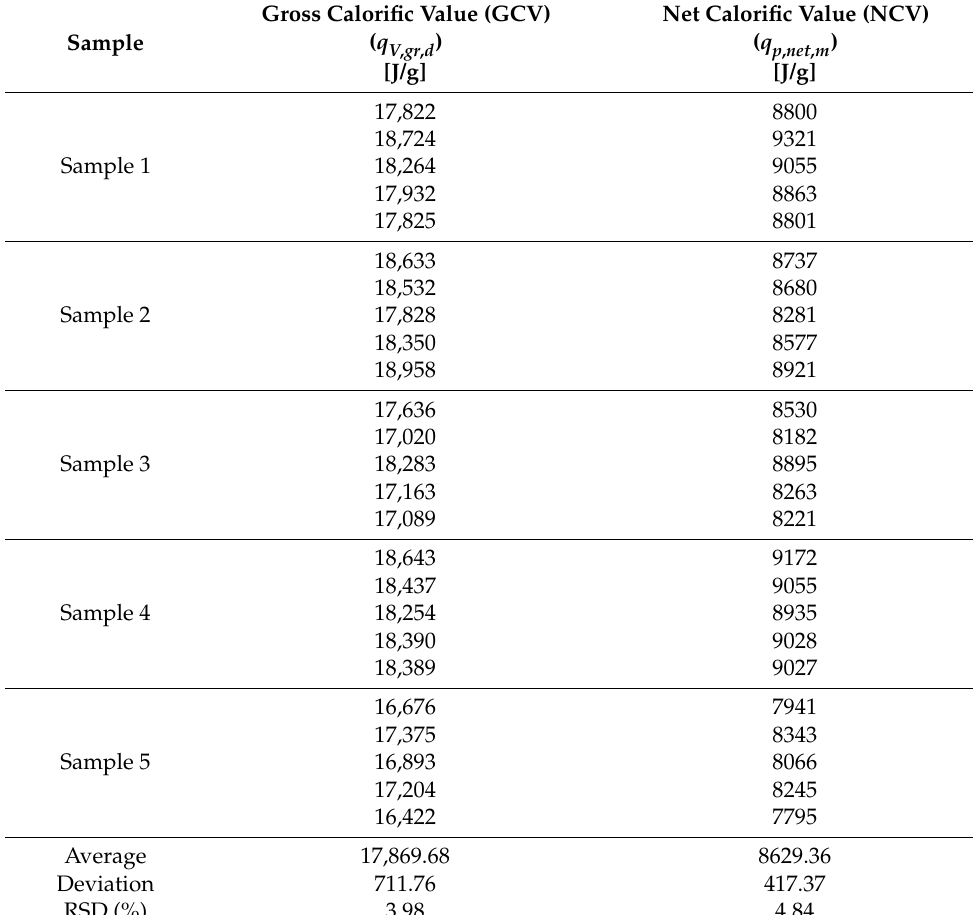
Table 5. Calorific value of the MSW